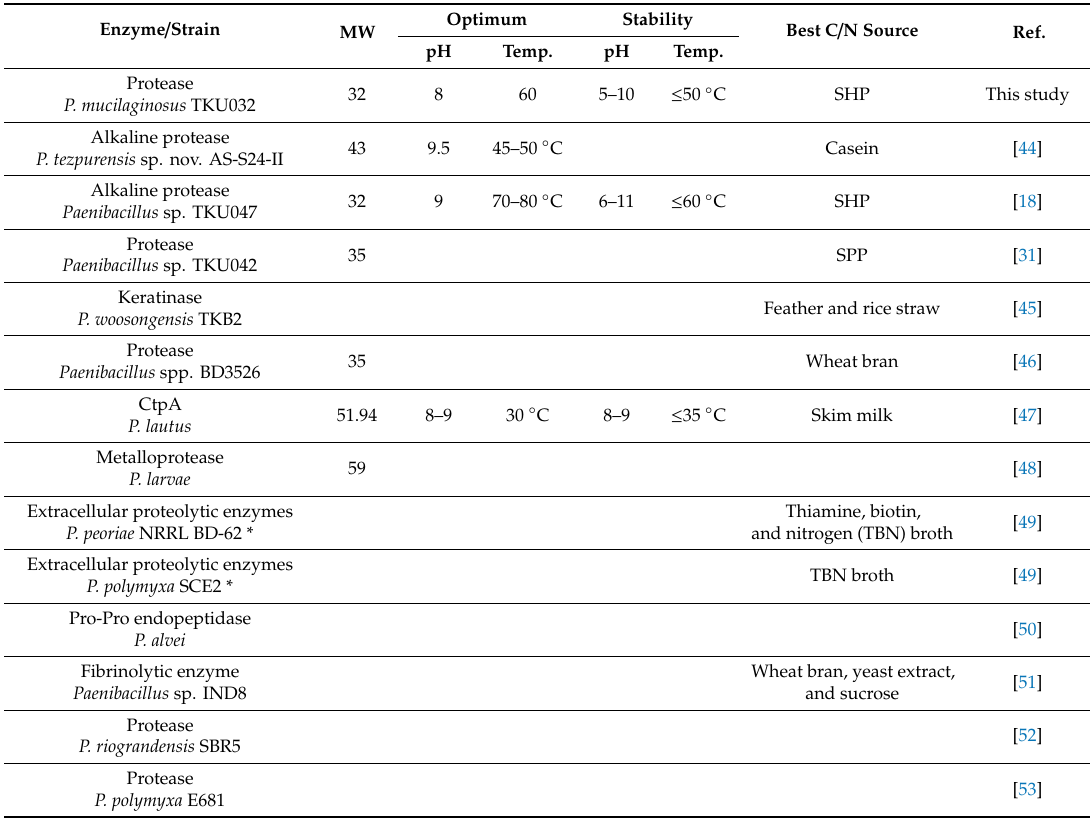
Figure 3. SDS-PAGE ( a ) and zymography ( b ) profiles of purified TKU032 protease. Table 2. Characteristics of protease from the Paenibacillus genus.